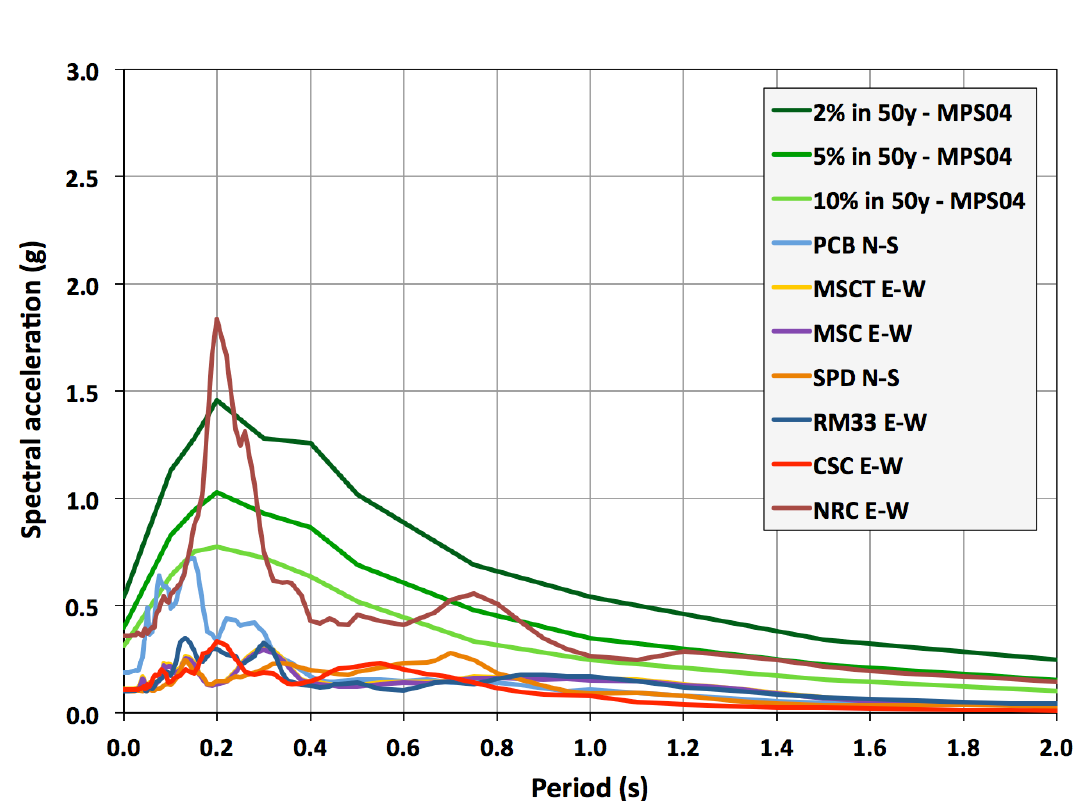
Figure 6. Comparison between the maximum horizontal acceleration response spectra (5% damping) of the Amatrice Mw 6.0 mainshock recorded at the stations located between 16 and 25 km from the epicenter and the UHS of MPS04 for soil class B, at a node located at about 20 km to the southeast of AMT, for 2%, 5% and 10% probability of exceedance in 50 years. The station codes refer to Figure 1 and Table 1.